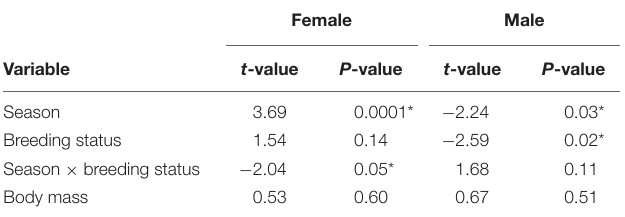
TABLE 5 | The statistical outputs of the effects of the season (non-breeding period/wet season vs. breeding period/dry season) and breeding status (breeding vs. non-breeding), their two-way interactions and body mass on the malondialdehyde (MDA) of 31 female and 35 male highveld mole-rats ( Cryptomys hottentotus pretoriae